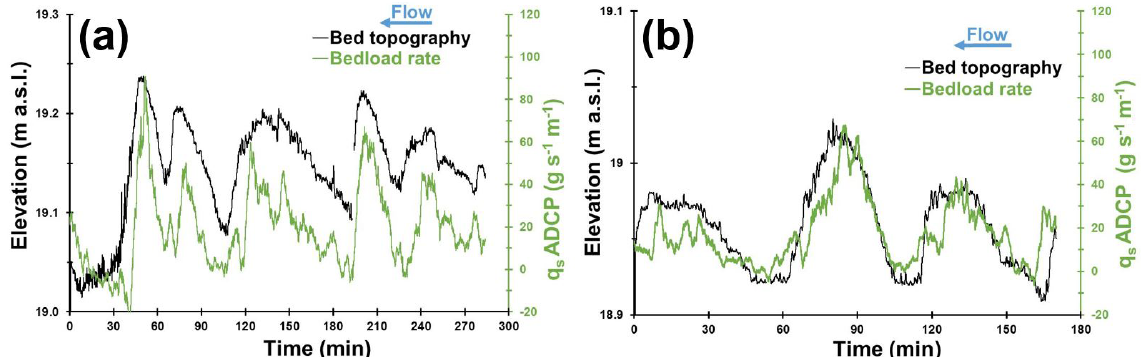
Figure 10. Bedload rates calculated using Eq. (15) and bed topography obtained during a static measurement performed using an aDcp: (a) survey done on 20 May 2020 ( Q = 470m 3 s − 1 ; mean water depth = 1.04m) and (b) survey done on 29 May 2019 ( Q = 210m 3 s − 1 ; mean water depth = 0.85m).